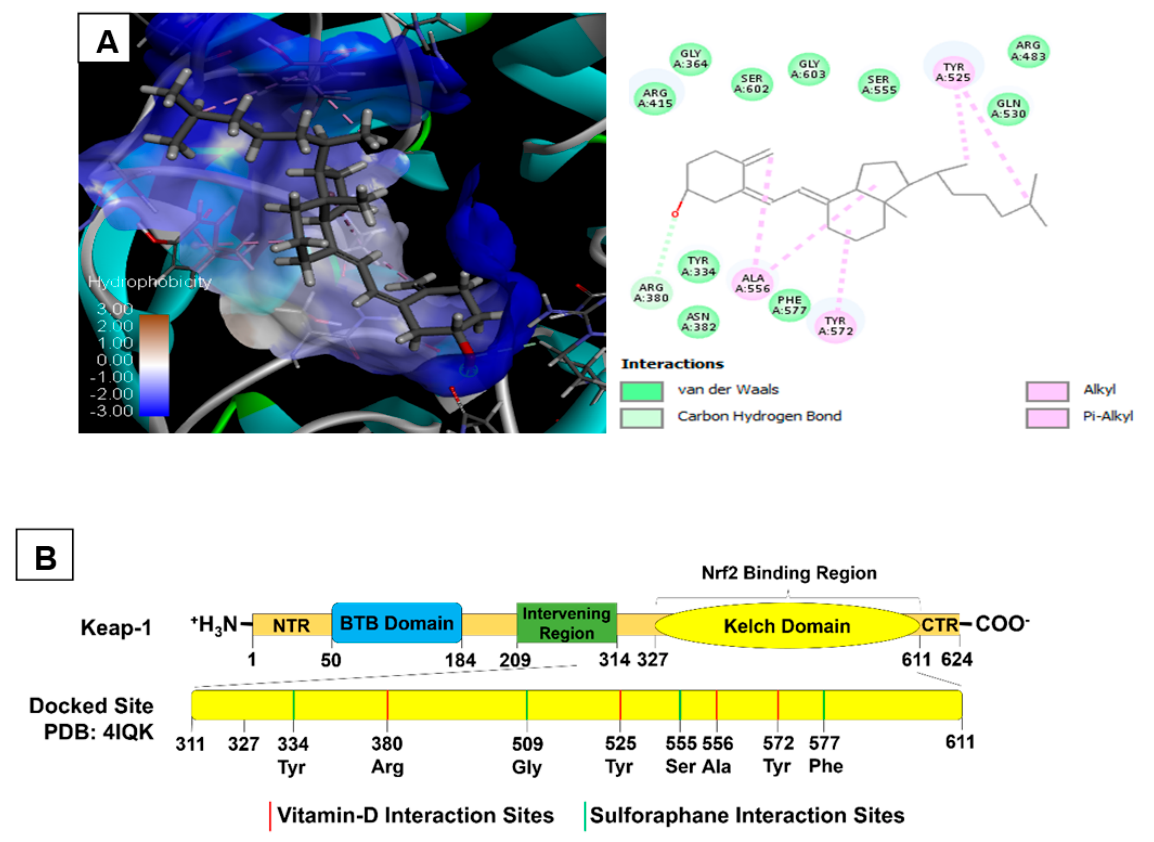
Figure 9. ( A , B ) Molecular docking of cholecalciferol to Keap1 (4IQK). Cholecalciferol showed a better binding affinity towards Arg380 in the carbon hydrogen bond. The target receptor is attached to cholecalciferol through Ala556, Tyr525, and Tyr572.